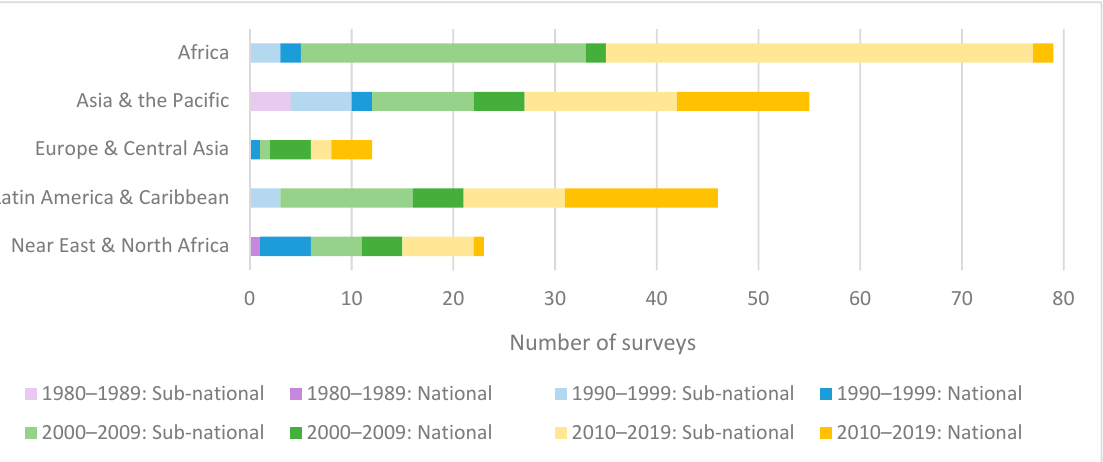
Figure 6. Number of national and sub-national dietary surveys conducted in LMICs from 1980 to 2019 by decade and geographical region, excluding longitudinal surveys. Data shown reflect the situation as of May 2022. Geographic regions are defined according to the FAO operational classification. Only LMICs are included for all regions, including Europe and Central Asia.